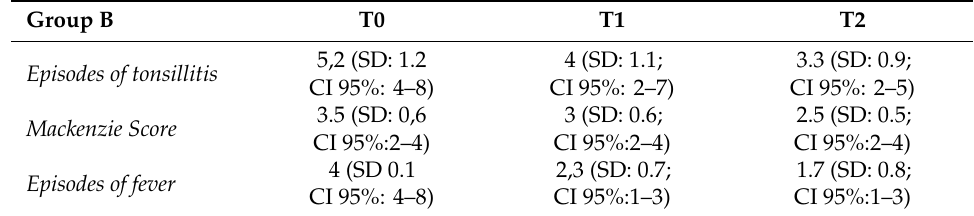
Table 2. Average of clinical data in Group B observed at the three di ff erent follow-up visits. Group B T0 T1 T2 Episodes of tonsillitis